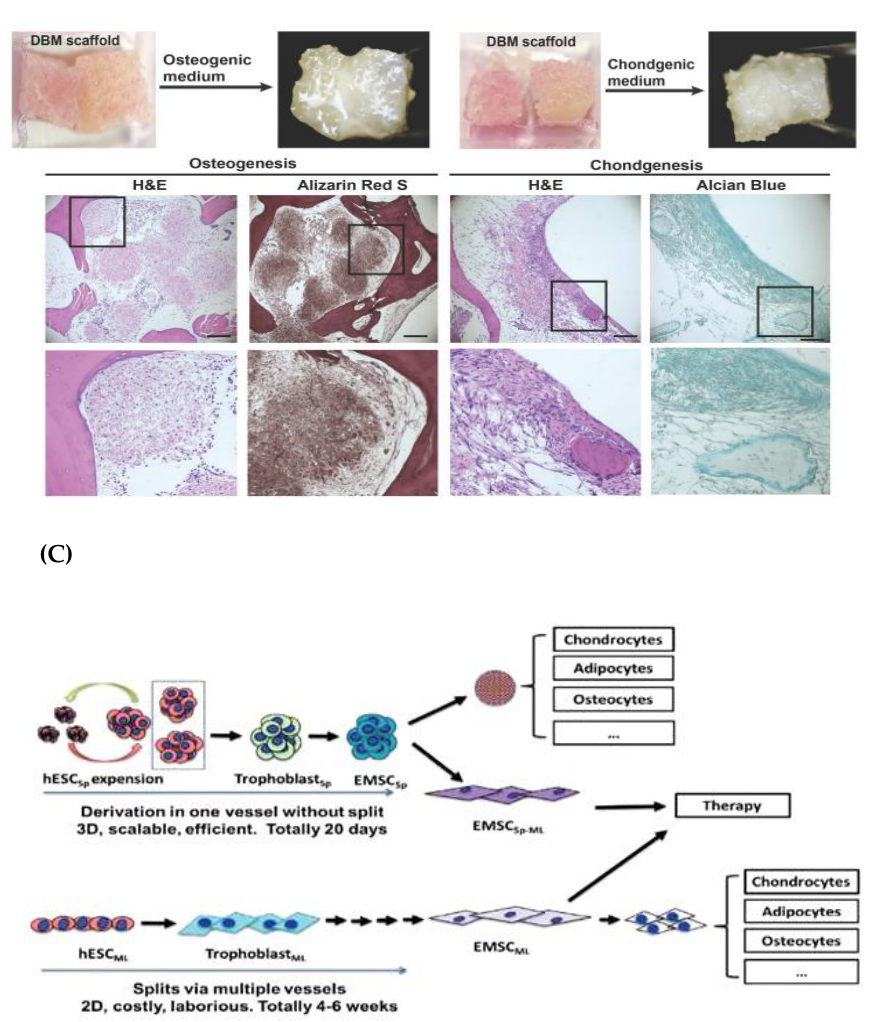
Figure 3. ( A ) Timetable and method for the generation of hESC-MSC SP from hESC SP . ( B )